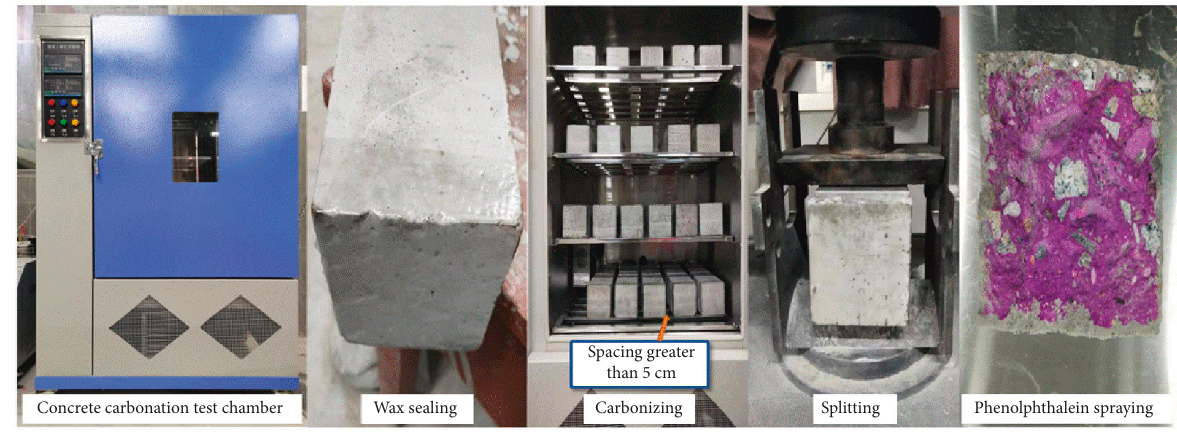
Figure 4: Process of concrete carbonation